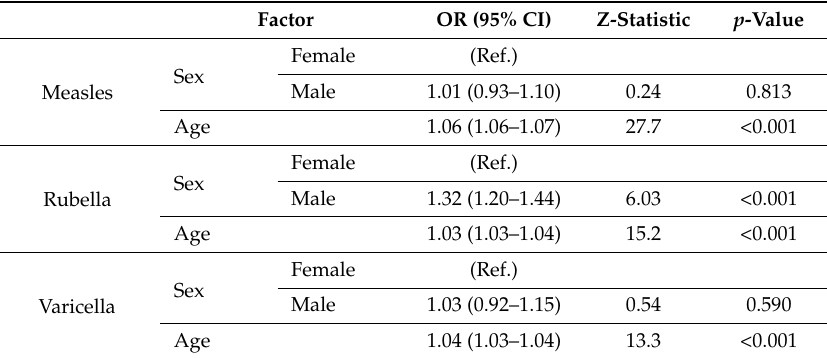
Table 4. Results from multivariable logistic regression models with the seropositivity status (Yes/No) as dependent variable and sex, age and country of origin as independent variables. The output for countries of origin is omitted. Factor OR (95% CI) Z-Statistic p -Value Female Sex Measles